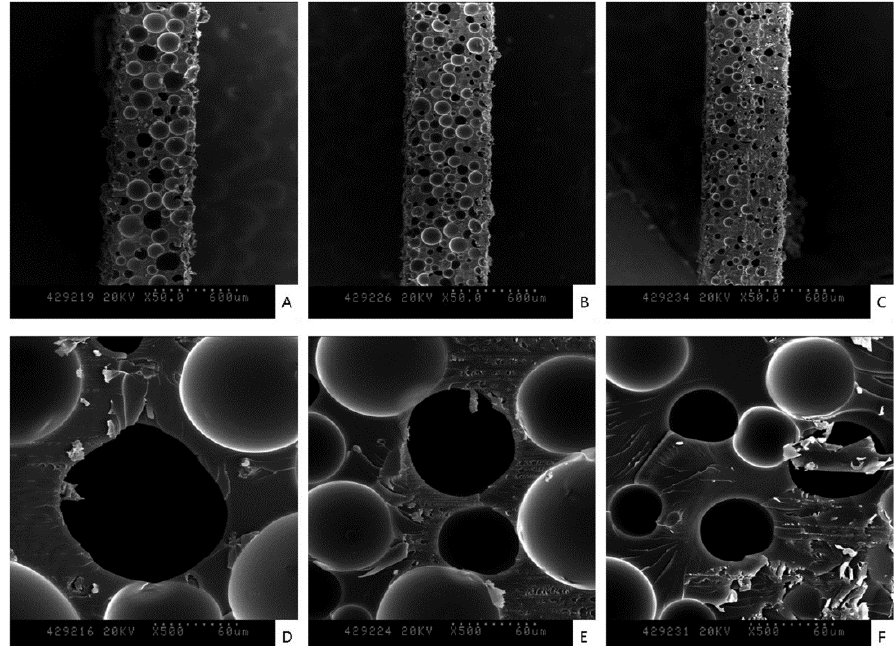
Figure 3. SEM images of 500-μm thick, 30, 40, and 50-pcf polyurethane discs. ( A , D ) The 30-pcf polyurethane disc (50× and 500×). ( B , E ) The 40-pcf polyurethane disc (50× and 500×). ( C , F ) The 50-pcf polyurethane disc (50× and